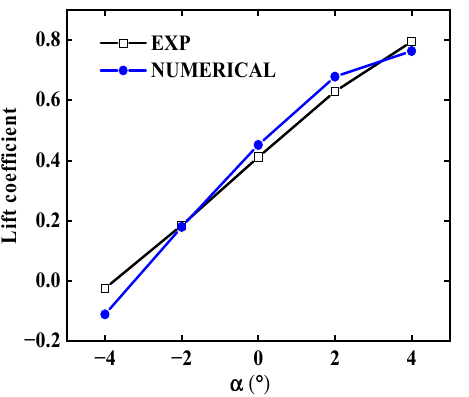
Figure 4. Comparison of numerical calculation values and experimental values.